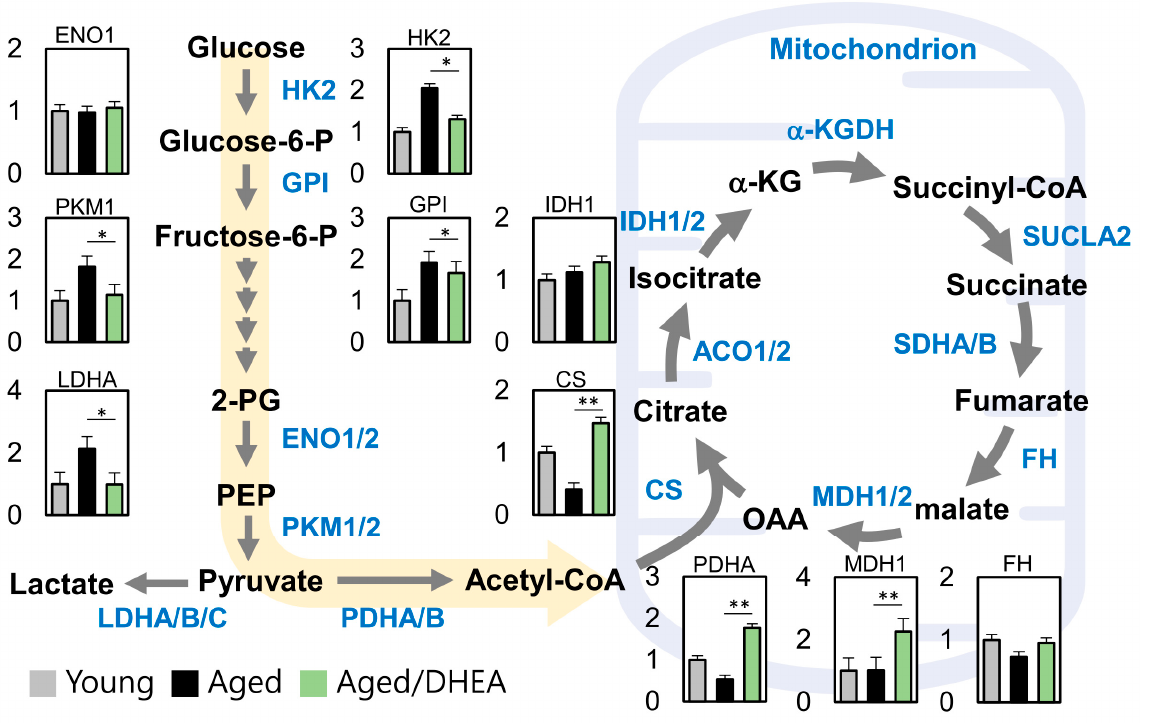
Figure 3. Metabolic reprogramming in the cumulus cells of aged infertile patients after DHEA treatment. A map of metabolic pathways and metabolite levels in glycolysis and TCA cycle pathways. * p <0.05 and ** p < 0.01.